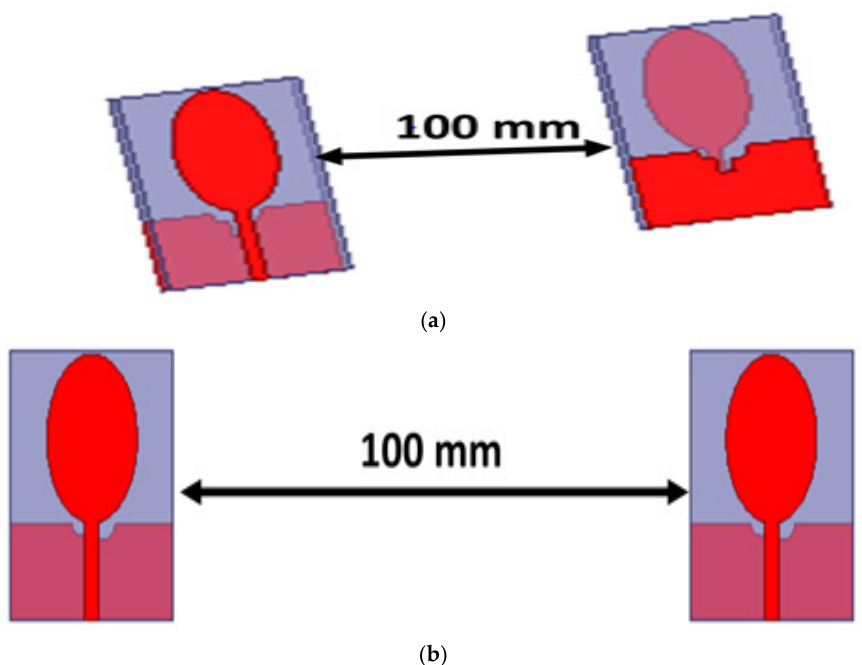
Figure 13. Time ‐ domain analysis with orientations, viz., ( a ) frontal and ( b ) lateral. Figure 13. Time-domain analysis with orientations, viz., ( a ) frontal and ( b ) lateral. In Equation (5), GD is the derivative of phase response to angular frequency.